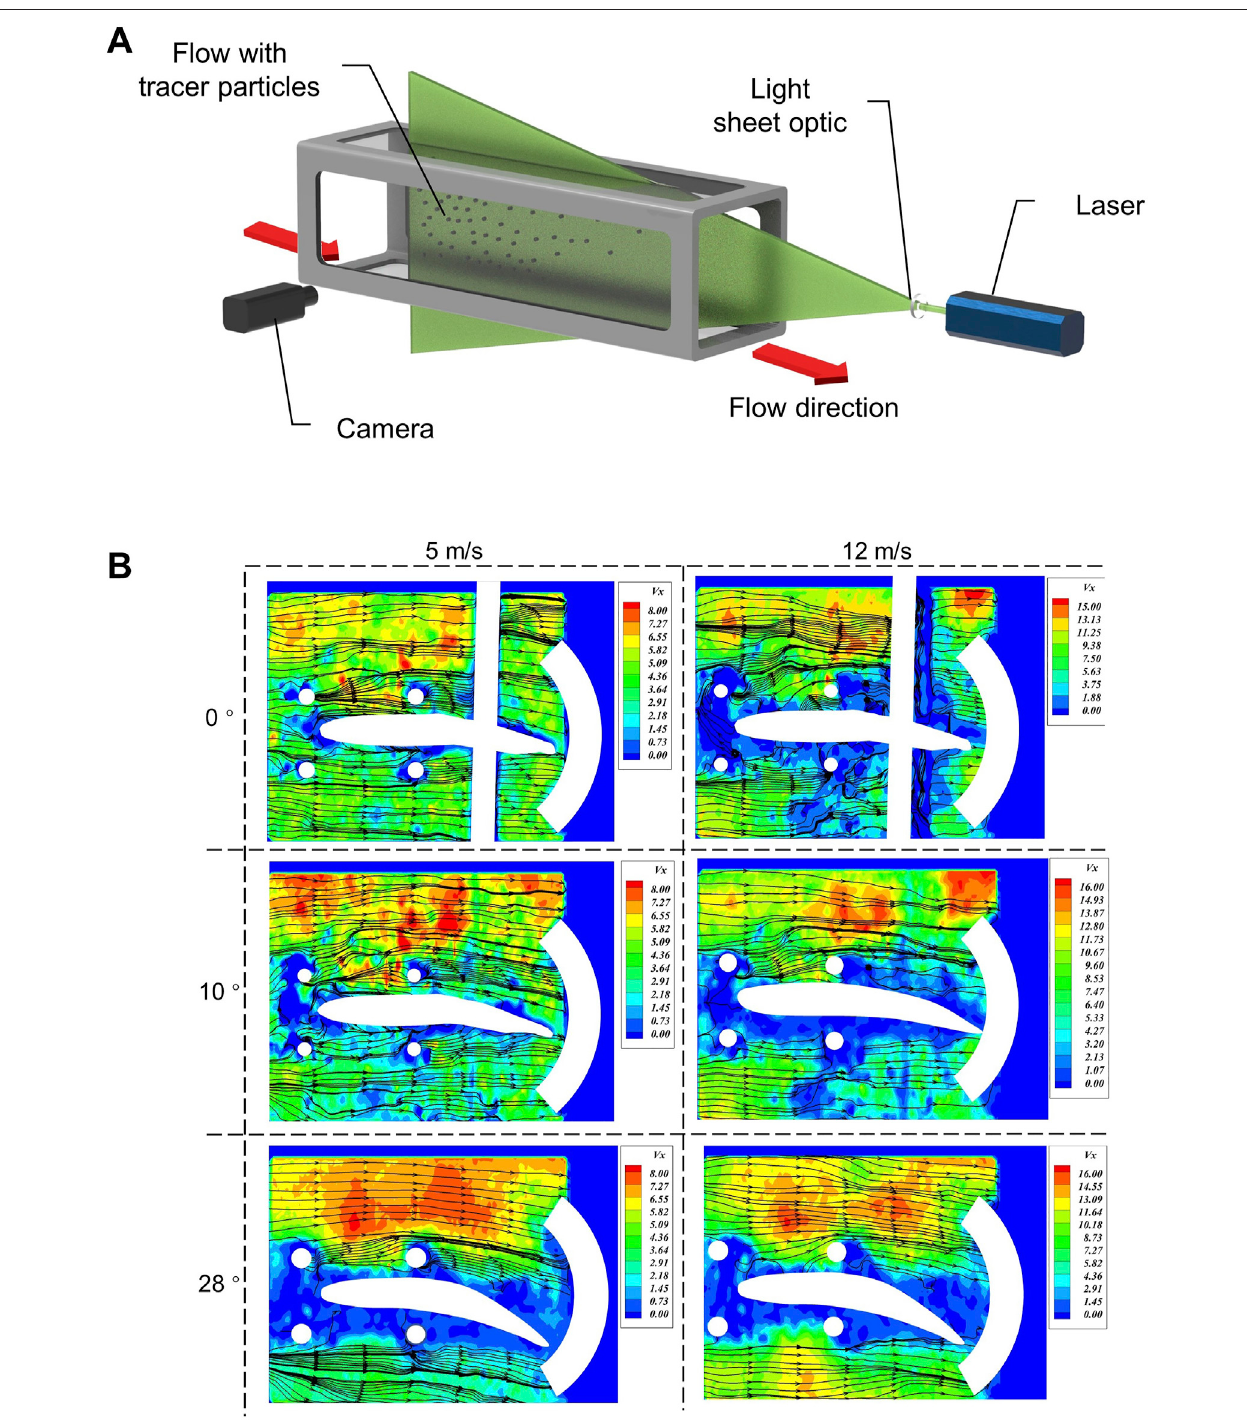
FIGURE8| Wind tunnel testtodetermine loadbearing capacity and aerodynamicresponse ofmorphing wings. (A) Awind tunnel test setupwithaPIV instrument; (B) Air fl ow velocity contours near morphing wing at different air- fl ow speeds and speci fi c chordwise angles.